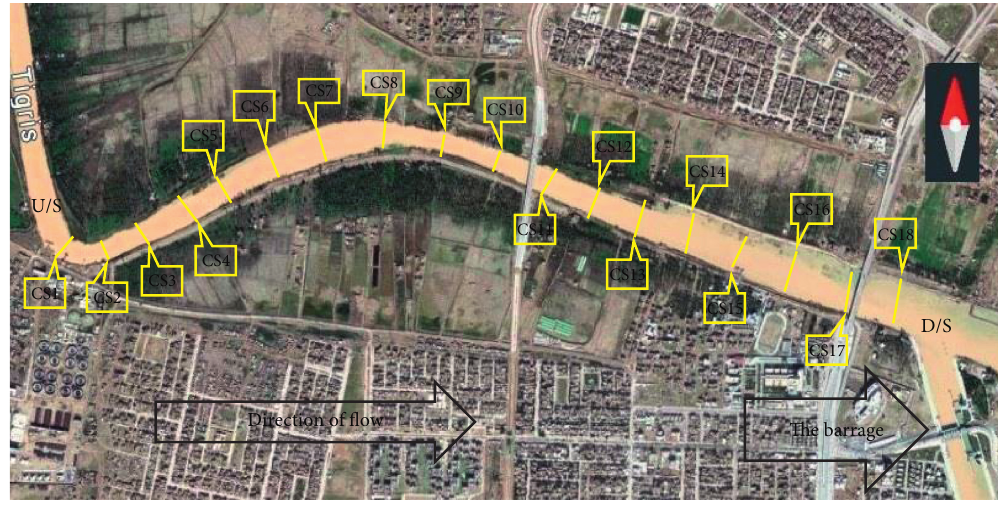
Figure 2: Locations of sections over study reach.